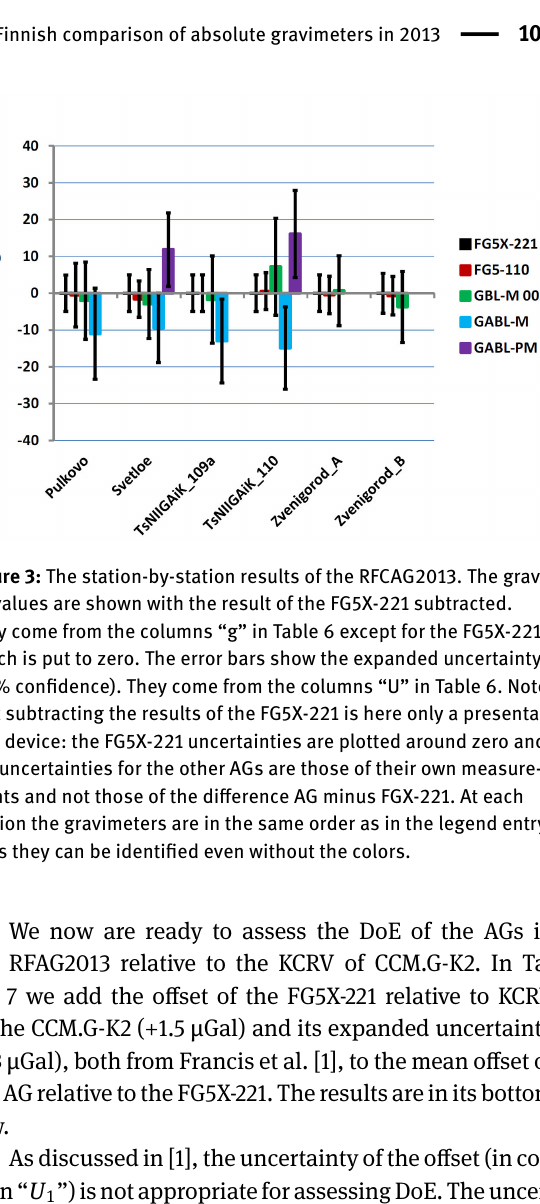
ues and their uncertainties are in the second-to-last row of Table 6. The last row contains the RMS of the uncertainties U r , needed in the sequel in the assessment of the Degree of Equivalence (DoE)¹ of the gravimeters.